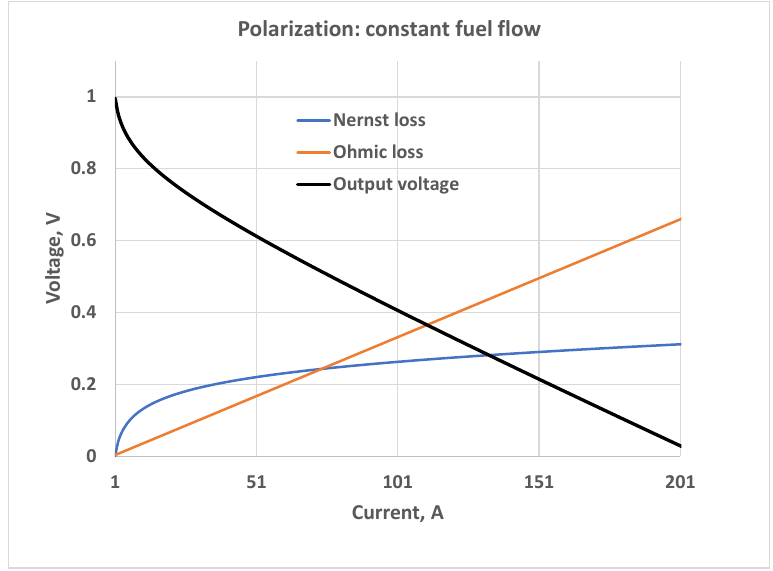
Figure 7. Polarization curve when hydrogen and oxygen input flow rates are held constant; the Nernst loss and the ohmic loss are plotted separately.